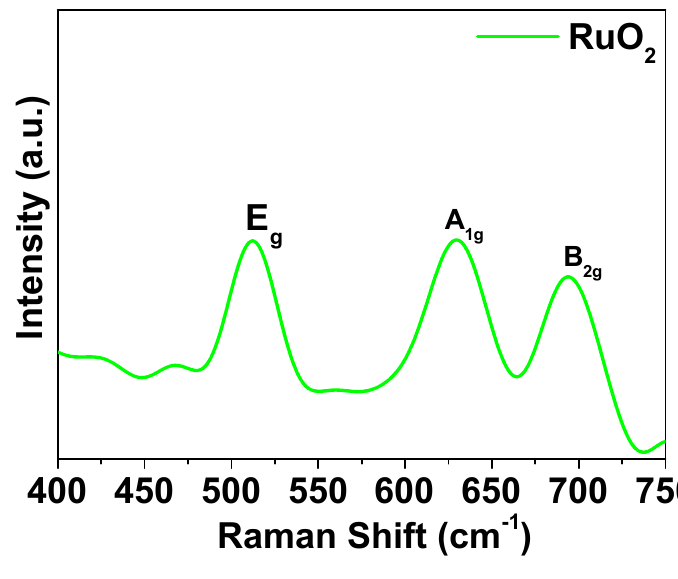
Figure 4. Raman spectrum of RuO 2 .